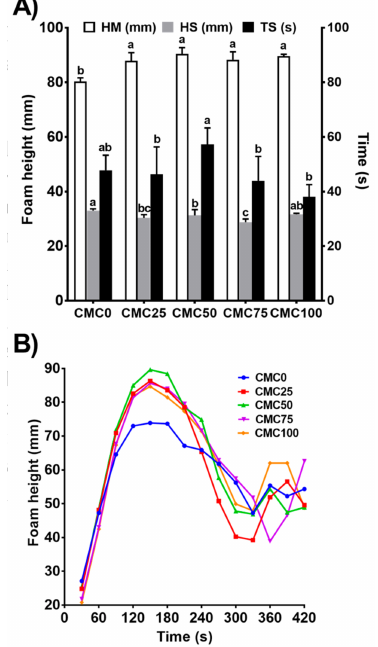
Figure 1. ( A ) Effect of CMC addition on mean foam height (HM, white), foam stability (HS, grey bars) and time stability (TS, black bars). Error bars represent SD ( n = 3 per treatment). Different letters represent statistically significant differences between treatments (post-hoc Tukey test); and ( B ) the effects of CMC addition on the change in mean foam height over time ( n = 3 per